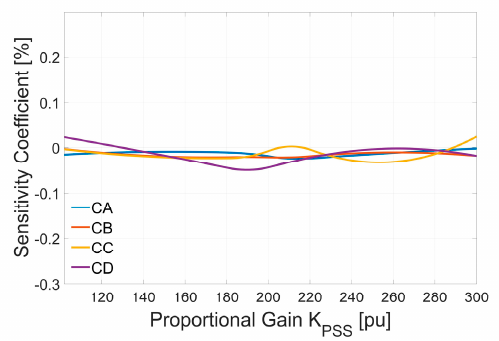
damping ξ e (TNF 1 ) related to K PI .